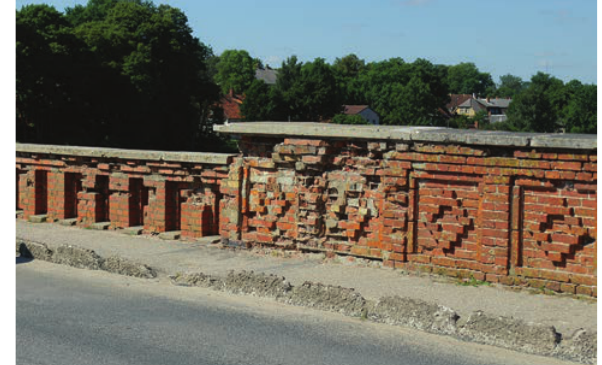
Fig. 8. Serious brick damages in the parapet structure